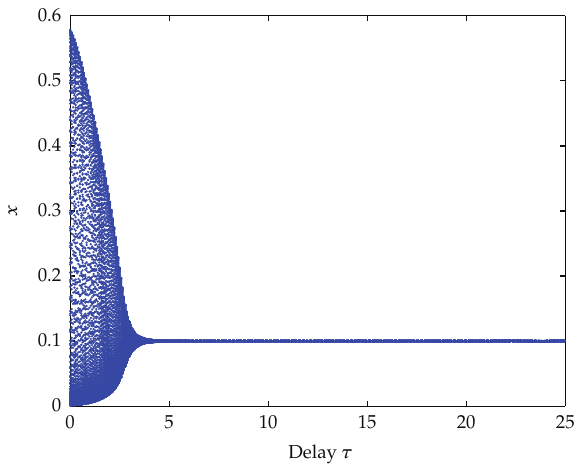
Figure 7: The relationship between ultimate oscillation range of mature prey and delay τ .